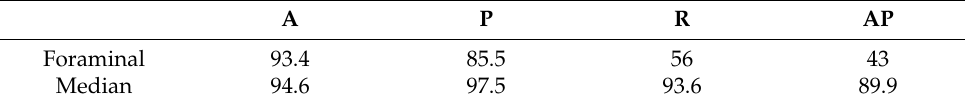
Table 3. CycleGAN model results